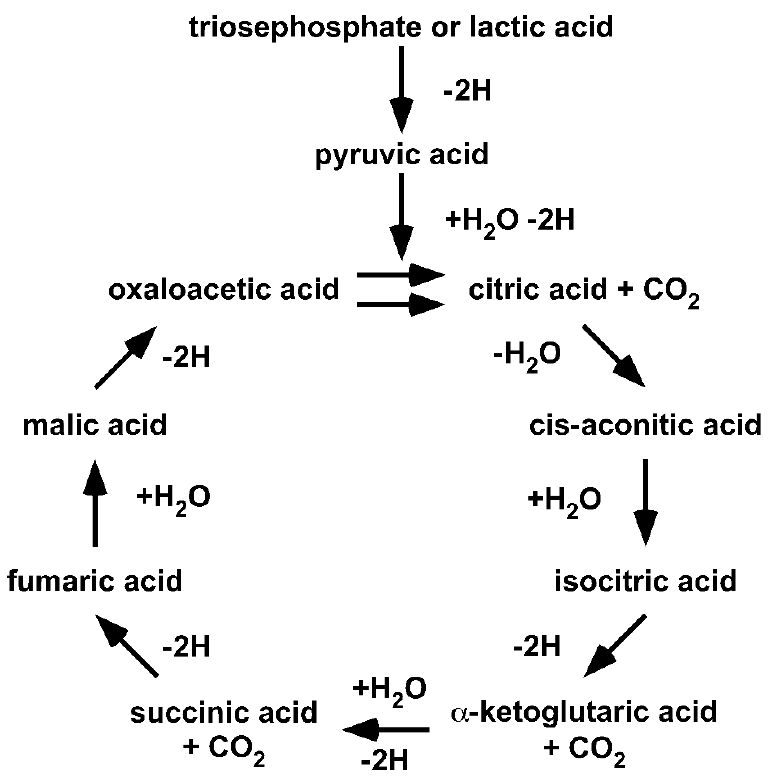
Figure 2. Krebs’ Original Citric Acid Cycle. This illustration is taken from H. A. Krebs’ Nobel Prize lecture in 1953 and first published 1937 [41–43]. H. A. Krebs received the Nobel Prize for his discovery of the Citric Acid Cycle. ©The Nobel